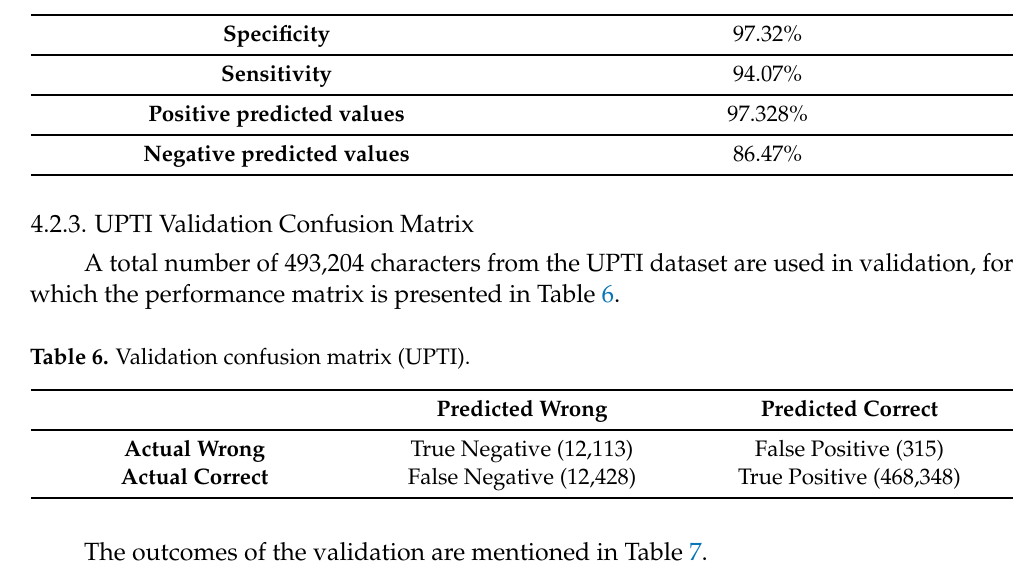
Table 5. Validation outcomes.